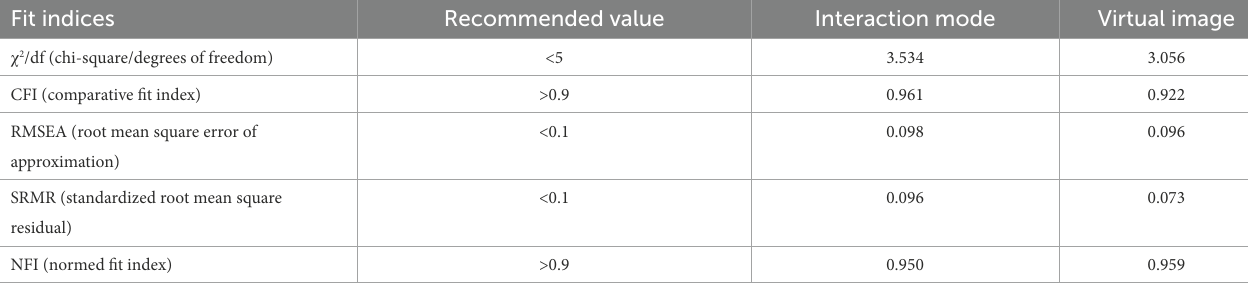
TABLE 4 Fit indices for the measurement model.